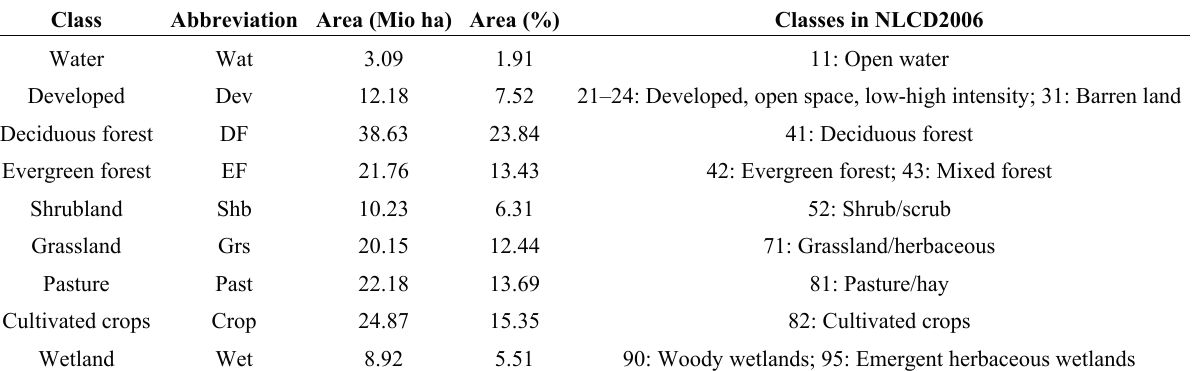
Table 1. Legend and area of each class from NLCD2006. Class 12: Perennial ice/snow was not present in the study